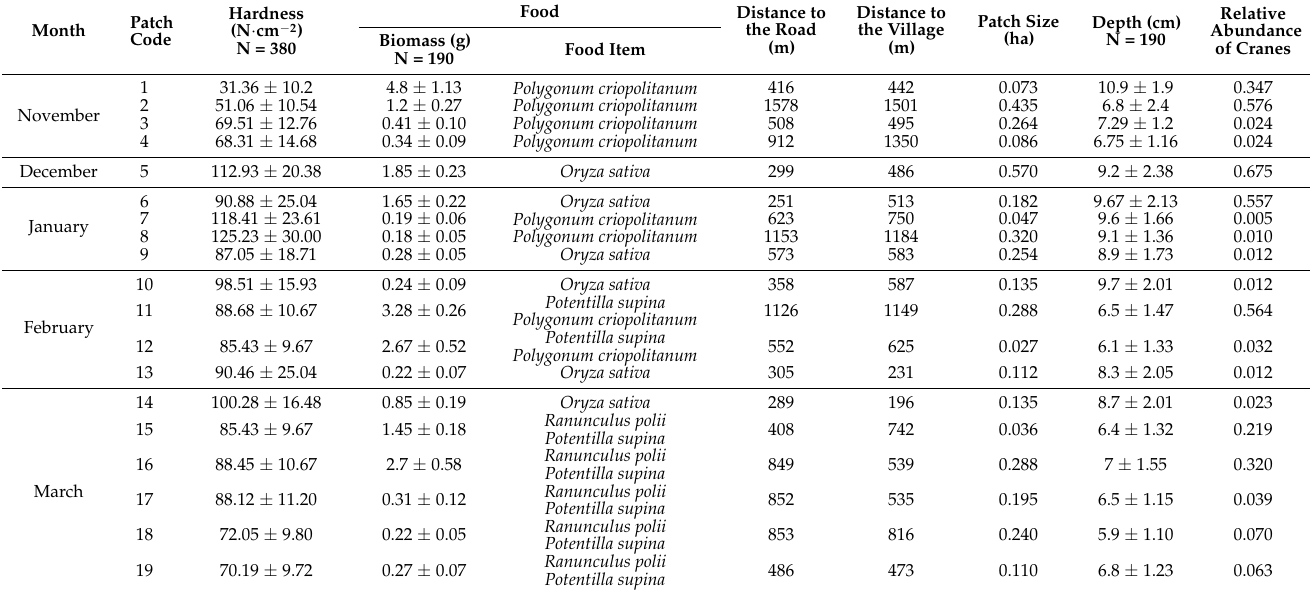
Table A3. Characteristics of the surveyed patches at Shengjin Lake (The food item was the main food resources for cranes).